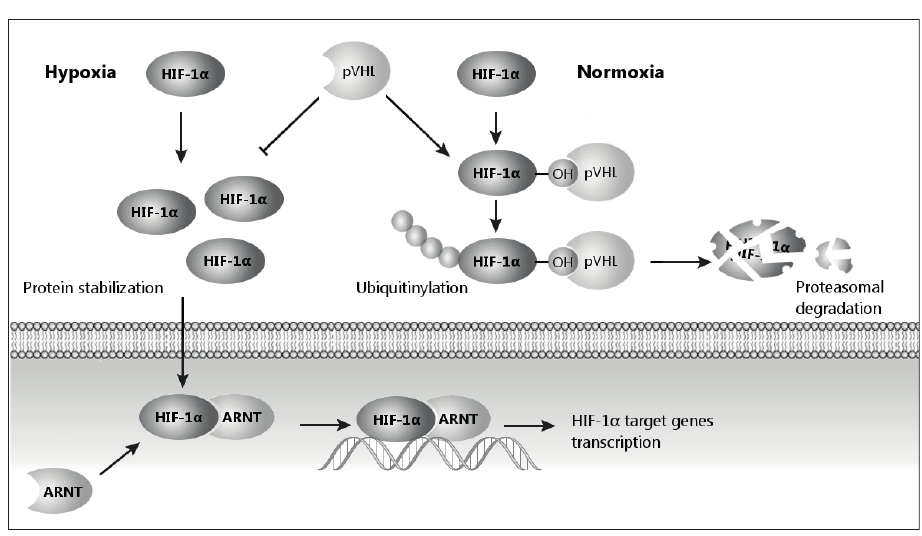
Fig. 1. Regulation of HIF-1α stability in hypoxia and normoxia (adapted according to ref. 41